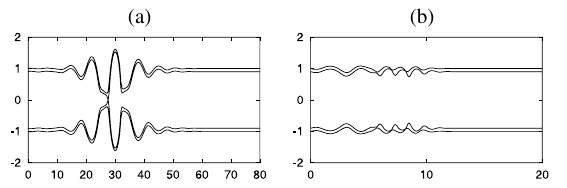
Fig. 8 Breakup profiles for ρ = 0 . 9, where ¯ u 2 = 1, η = 0 . 1, σ = 1 and ¯ b = 0 . 1; (a) ¯ u 1 = 1, Wb = 5 and ω = 1 . 6, while (b) ¯ u 1 = 0, Wb = 24 . 2 and ω = 0 . 727.